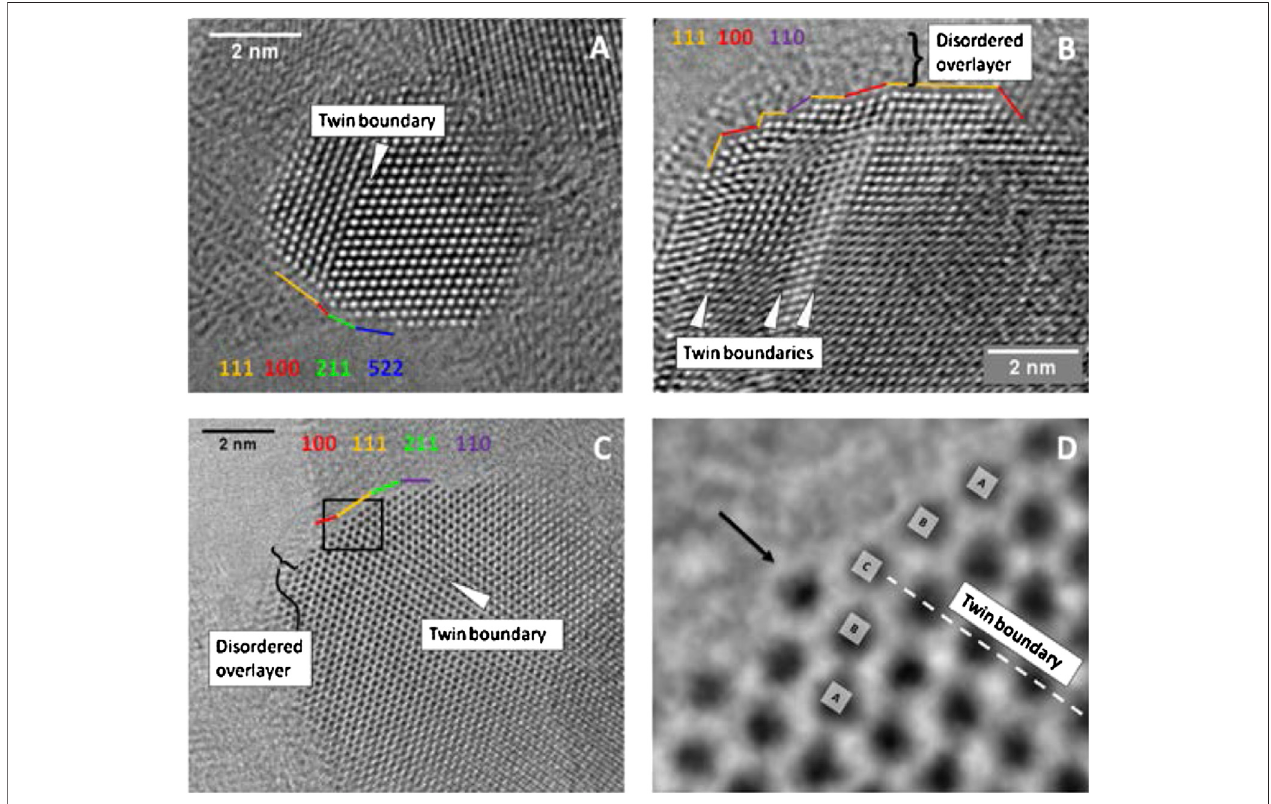
FIGURE 7 | (A-C) Aberration-corrected HRTEM images of Cu particles in the commercially active Cu/ZnO/Al 2 O 3 catalyst. (D) is a zoom-in of the marked area in (C) (Behrens et al., 2012). Reproduced with permission from American Association for the Advancement of Science.